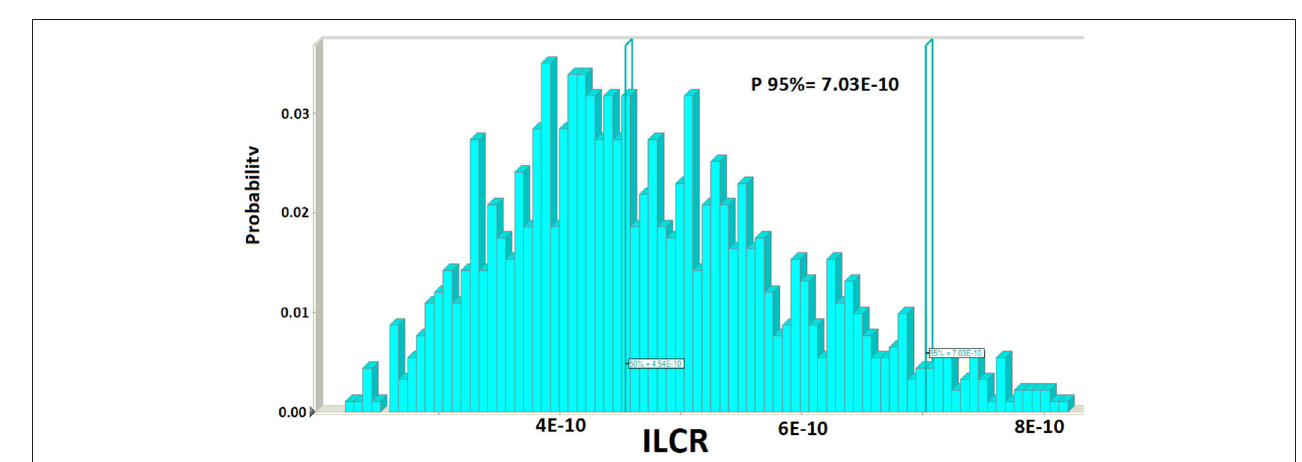
FIGURE 3 | Heat map of PAH in baby